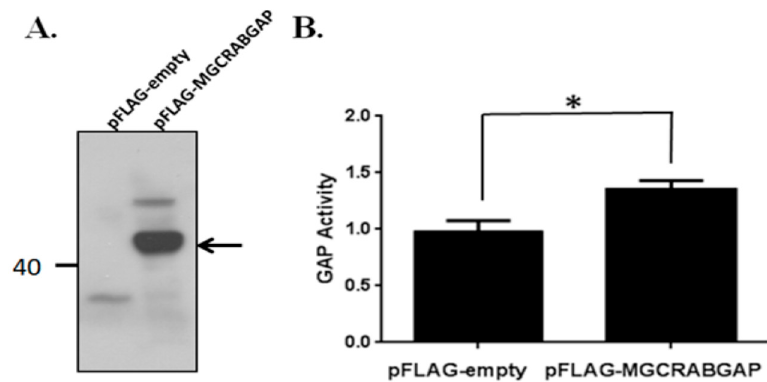
Figure 1. Male Germ Cells Rab GTPase-Activating Proteins (MGCRABGAP) expressed GTPase-activating activity in NT2D1 cells; ( A ) The total cell lysates of NT2D1 cells transfected with the empty pFLAG or pFLAG-MGCRAB vector were immunoblotted; Blots were probed with an anti-FLAG antibody; The arrow points to MGCRABGAP; ( B ) The lysates were used to evaluate GTPase-activating bioability ( n = 4); Statistical significance (* p < 0.05) was determined via paired t -test methods; NT2D1: NTERA-2 cl.D1cell line; GAP: GTPase-Activating Protein.